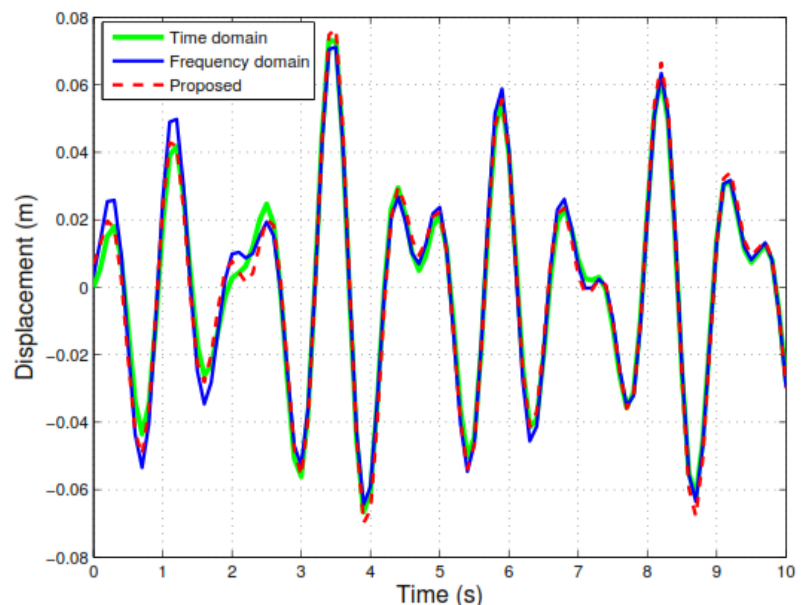
Figure 3. The response comparison at the top of the tower in the y direction with a zero initial condition when an external load is applied.